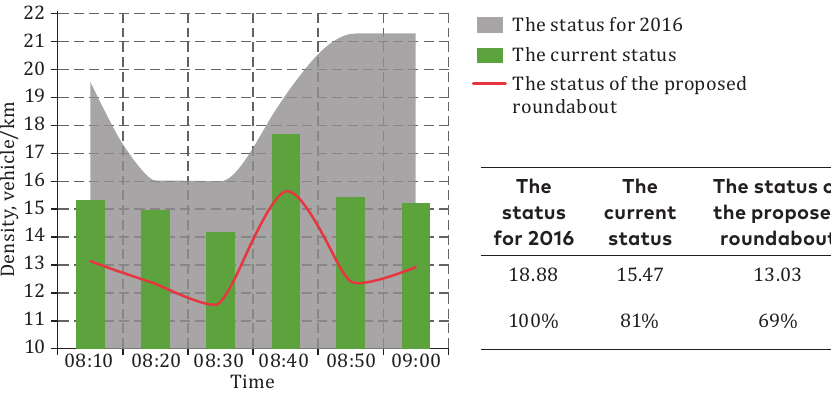
Figure 18. Vehicle density-time change